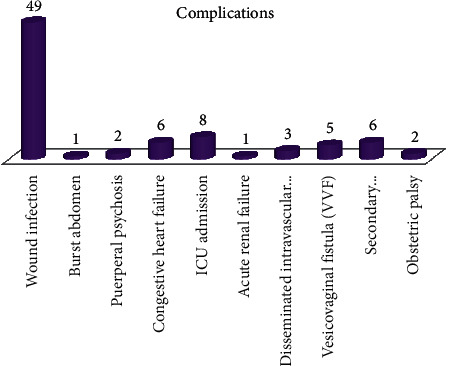
Bar chart showing complications.